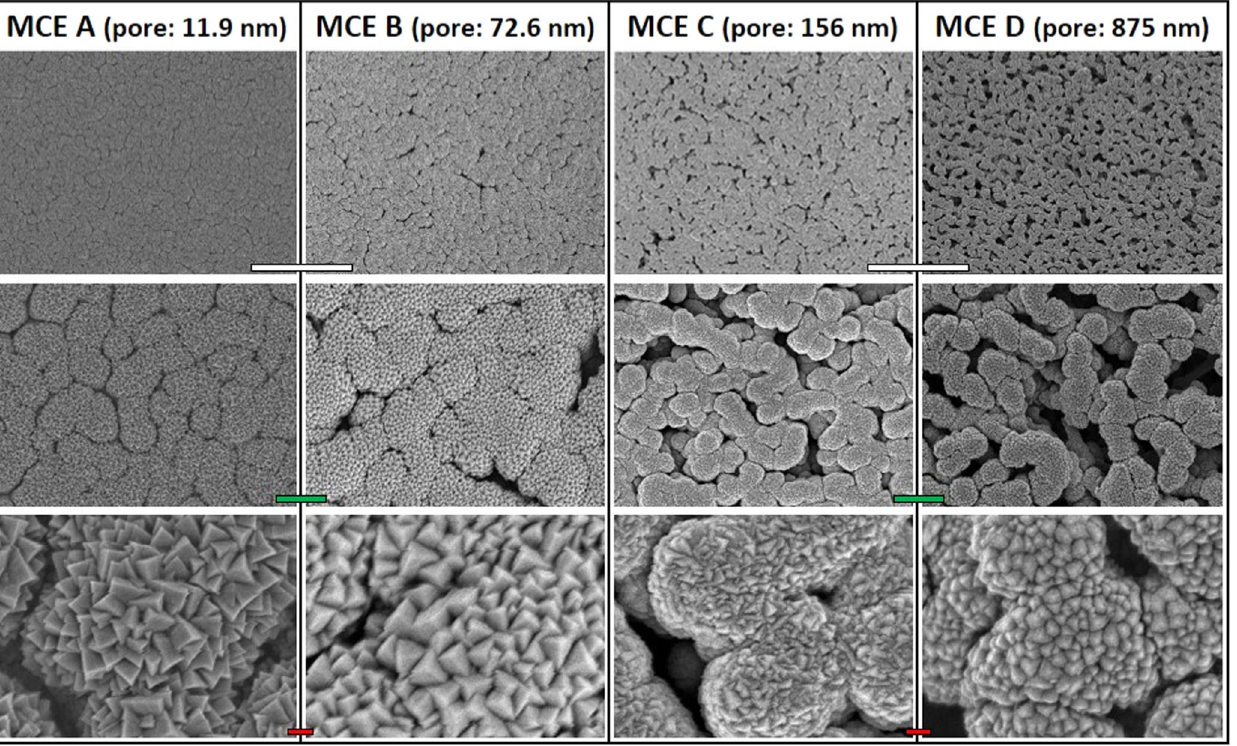
Fig. 4 Microstructure of coated MCE membranes. Surface-view SEM micrographs of four coated MCE membranes (MCE A, MCE B, MCE C, and MCE D) at various magni fi cations with their respective average surface pore sizes. White, green, and red scale bares represent 10 µm, 1 µm, and 100 nm, respectively.